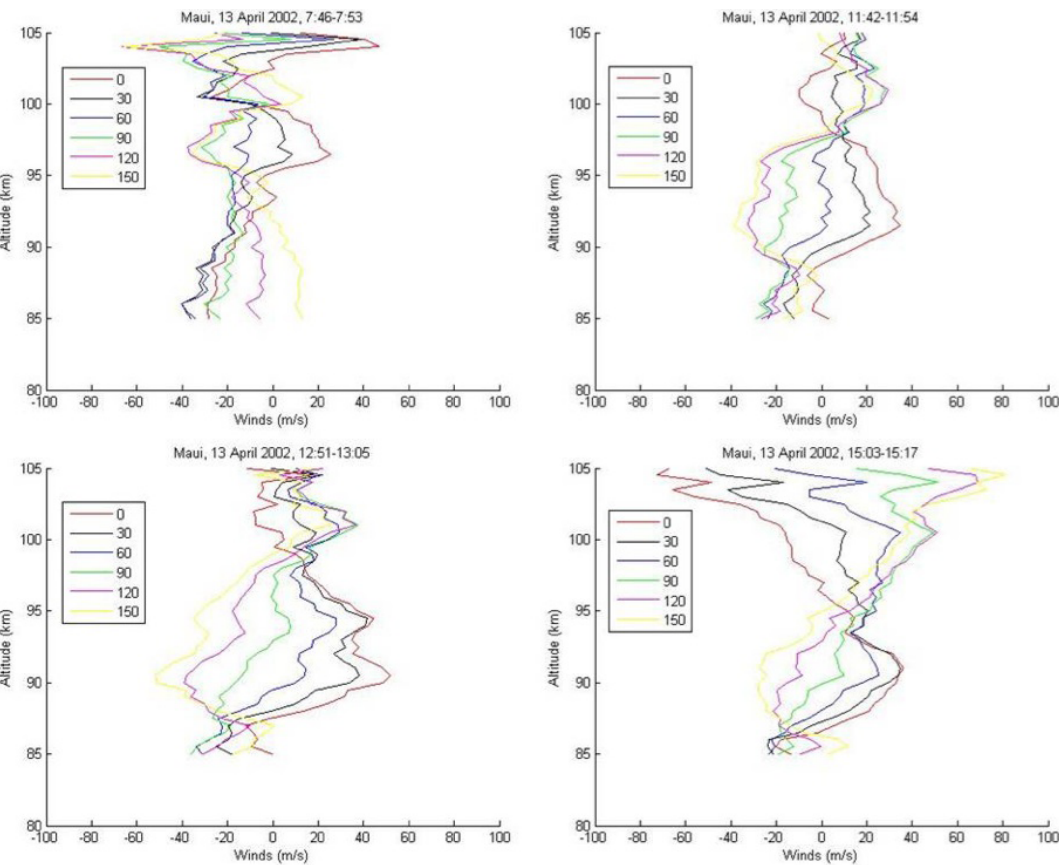
Fig. 2. Wind profiles showing shears and and the inflection point for varying vertical orientations at different stages of the observing period for 13 April 2002. The legend refers to the degrees of the direction for the corresponding profile.